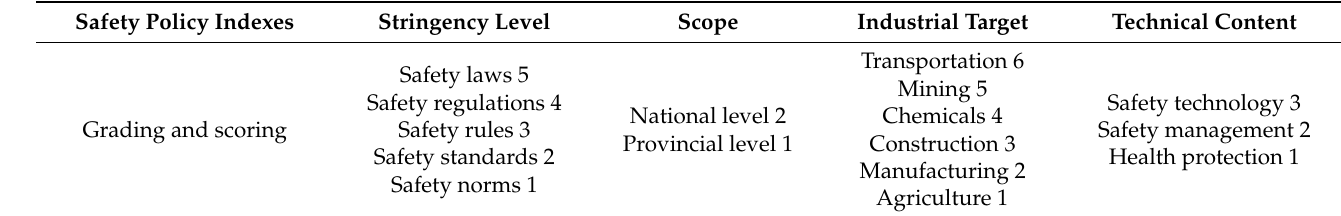
Table 4. Safety policy indexes and